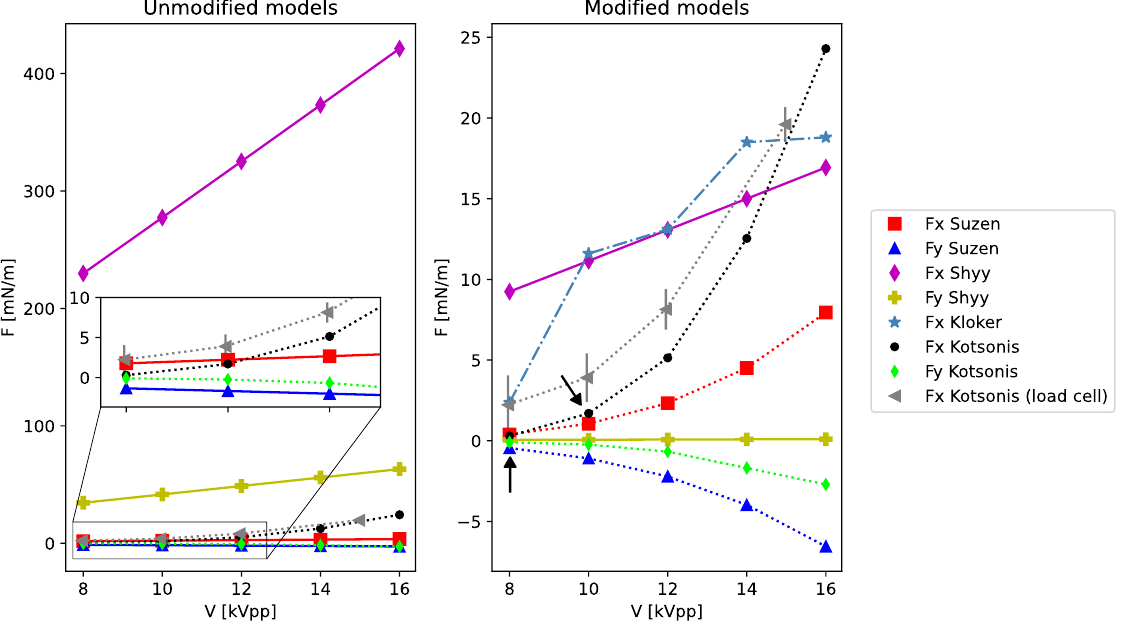
Figure 9. Effect of voltage at 2 kHz (case 1 setup) on the force components, unmodified models on the left, modified models on the right. The black arrows show where the numerical results are close to the reference